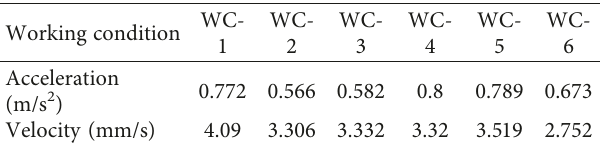
Figure 12: Peak velocity values in Y and Z directions. Table 1: Peak accelerations and peak velocities of X direction at point 5.